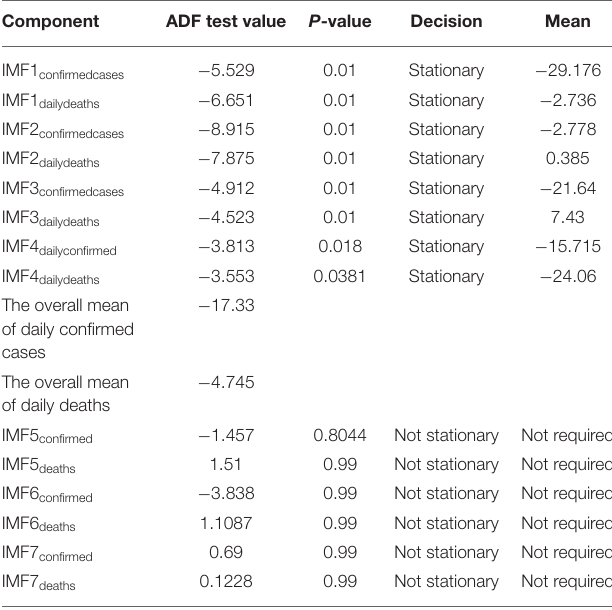
TABLE 2 | ADF test results along with the overall mean for France. Component